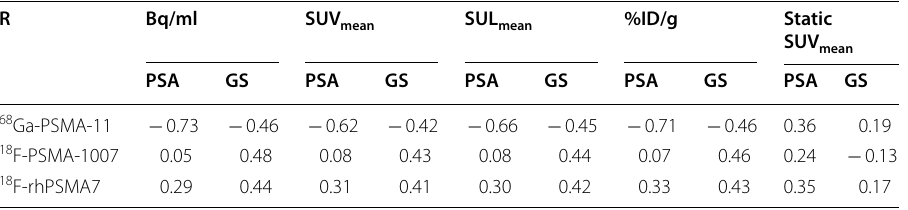
Table 2 Correlation coefficients ( R ) of the computed PSMA TACs with prostate-specific antigen (PSA) values and Gleason scores R Bq/ml SUV mean SUL mean %ID/g Static